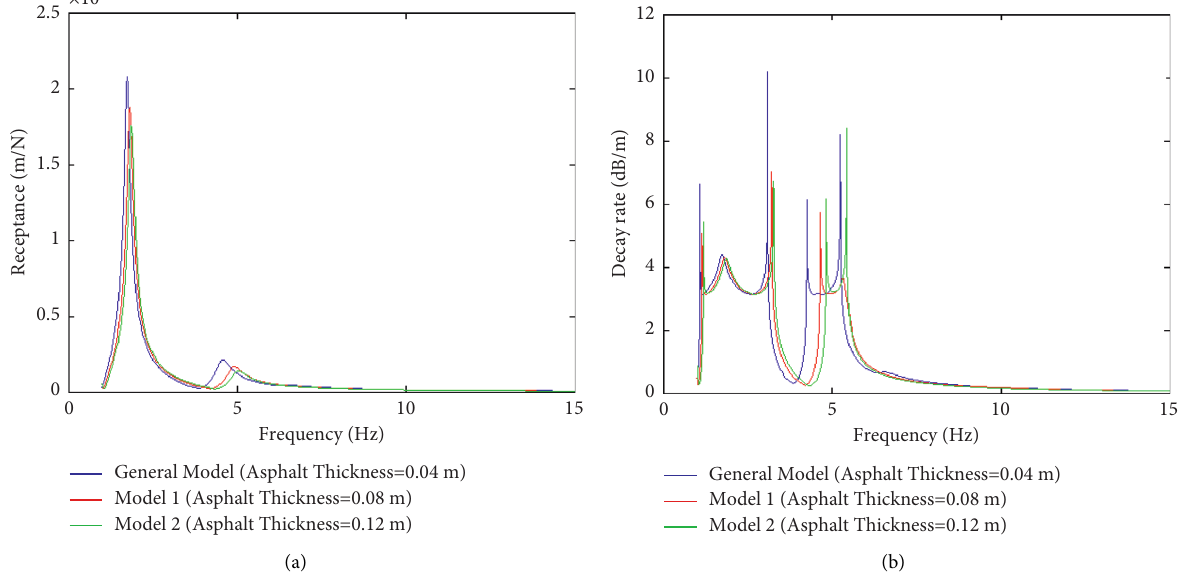
Figure 10: Effect of thickness changes on receptance and the decay rate of ABL: (a) effect of modulus changes on receptance and (b) effect of modulus changes on the decay